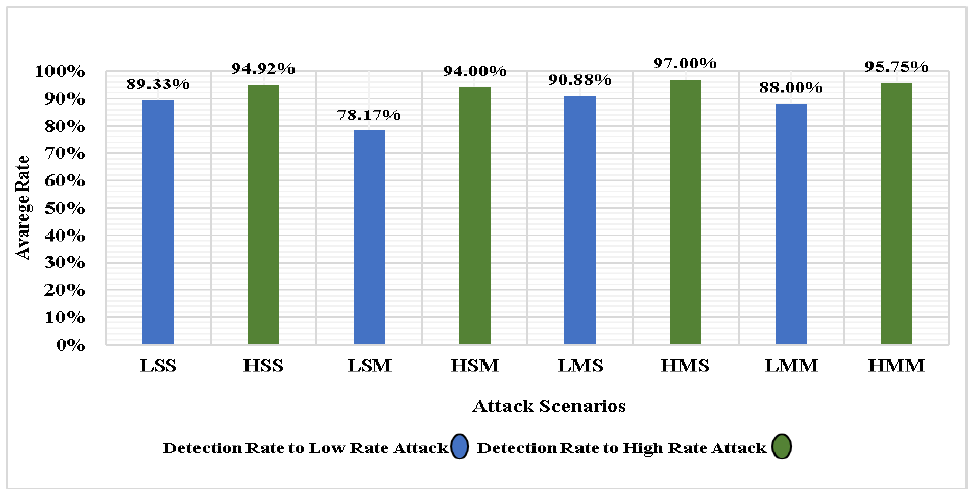
Figure 5. Comparison of the average DR of low-rate and high-rate attacks in using simulation scenarios.